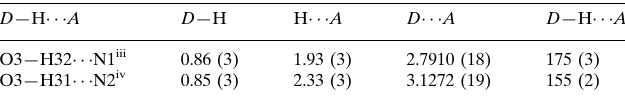
Hydrogen-bond geometry (A˚ , (cid:3)